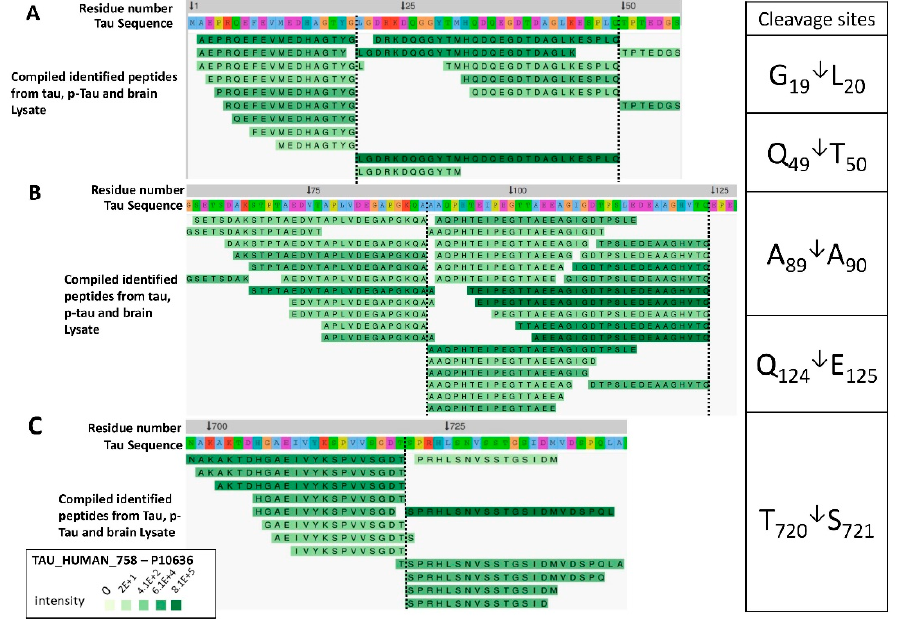
Figure 6. View of a customized Peptigram peptide alignment map compiled from tau, p-tau, and mouse brain lysate. The peptides were aligned to fit the longest human tau precursor protein (accession #: P10636; 758 a.a.). The representative peptides aligned were obtained by filtering and compiling peptides identified from tau, p-tau, and brain lysate digested by calpain-1. The black horizontal dotted lines display the predicted calpain cleavage sites which are summarized on the table to the right of the figure. The alignments represented are retrieved by ProViz and were further modified [26]. Peptides from the input data are highlighted in green color. The intensity of each peak detected by mass spectrometry is represented by a green color gradient, the darker the green color the higher the intensity. ( A ) This alignment is generated from tau-758 starting from the N-terminal domain: a.a. 1–57 ( B ) covers amino acid 60–128 and ( C ) cover amino acid 698–744.